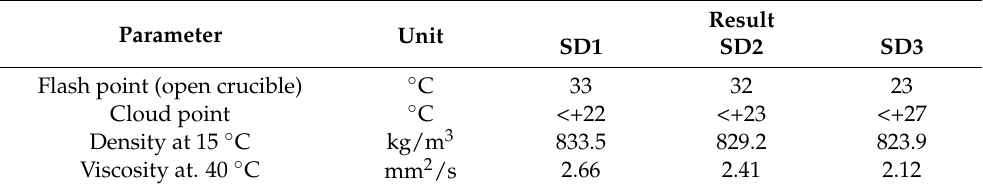
Table 3. Basic physicochemical parameters of mixtures (compositions). Parameter